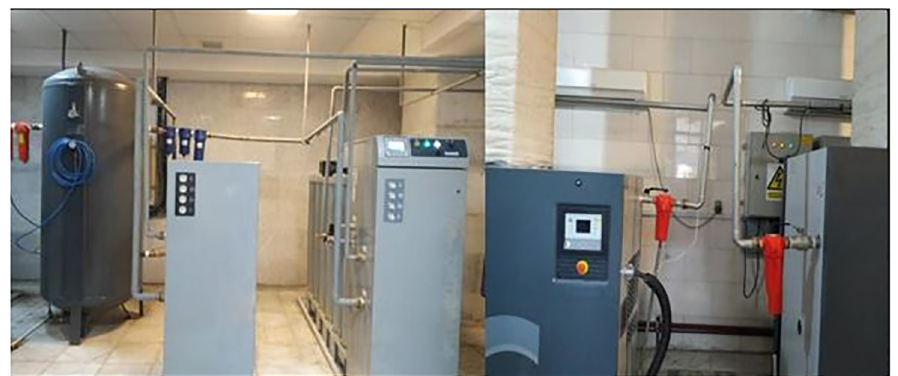
Fig 1. The picture of the PSA technology in the